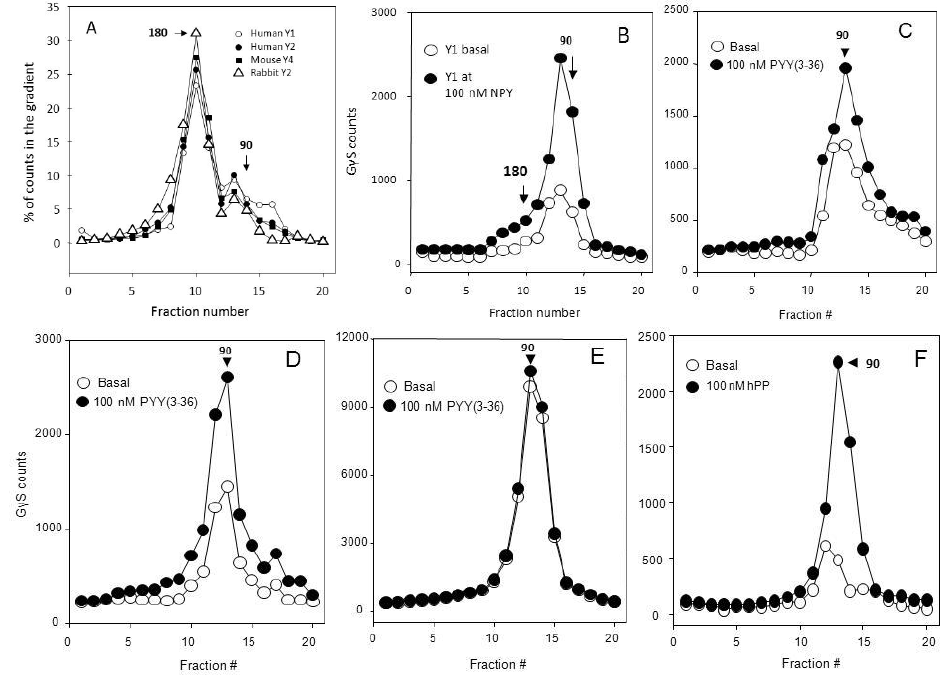
Figure 3. The Y receptors expressed in CHO cells and rabbit kidney Y2 receptors are largely detected as 180 kDa heteropentamers. The rabbit brain Y2 receptors are however in 90 kDa complexes with G i/o (see Figure 3 and graph 3E in this figure). The Gi α subunits in heteropentamers ( A ) are activated by respective agonists into 90 kDa complexes with receptor monomers: ( B ) CHO-Y1; ( C ) rabbit kidney Y2; ( D ) CHO-Y2; ( E ) rabbit piriform cortex; ( F ) CHO-Y4. All assays used 50 µg particulate